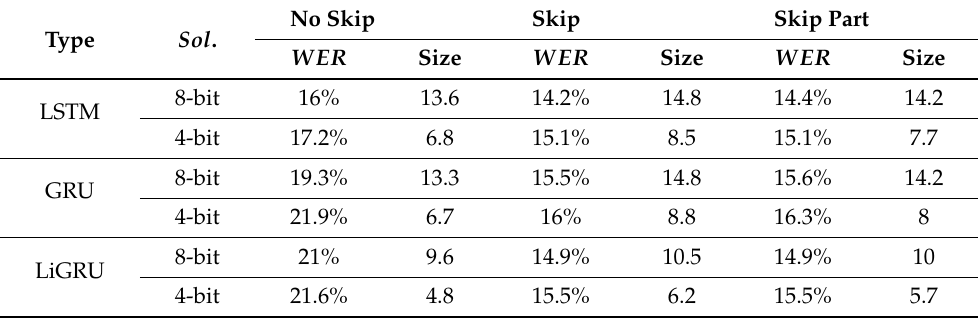
Table 1. The effect of selected path skipping during integer quantization of LSTM-, GRU-, and LiGRU-based models. The effect is evaluated at 8-bit and 4-bit quantization. The error and size are evaluated at three cases: no skip—no path skipping is applied; skip—path skipping is applied to all model layers; skip part—path skip is not applied to last two recurrent layers in the model. WER is the testing word-error-rate of the